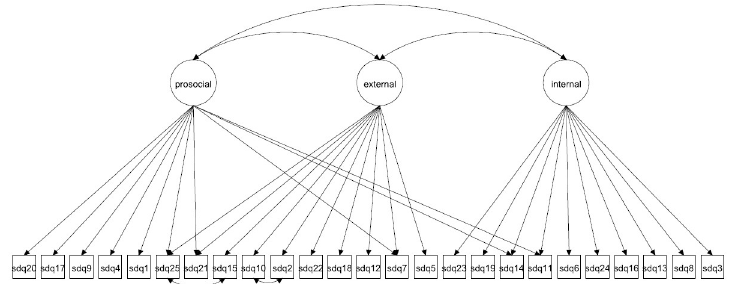
Fig 6. 3-factor model with cross-loadings and correlated errors for minor factors (Model